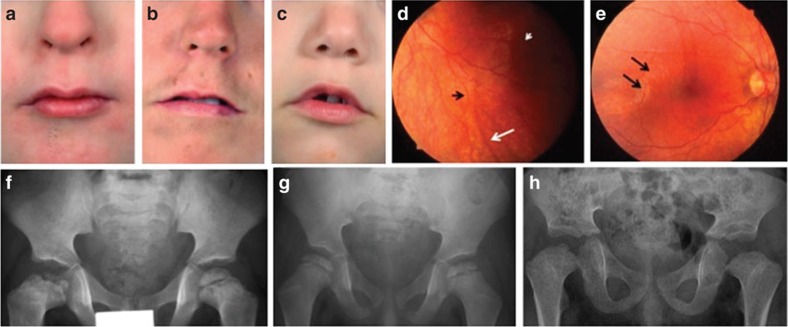
Facial, retinal and skeletal features of Roifman Syndrome.Facial dysmorphic features (a–c) include a markedly long philtrum, thin upper lip and down-turned corners of the mouth. Retinal features are displayed for patient 3 at age 4 years: arteriolar attenuation (d, black arrow), wrinkling of the inner limiting membrane (d, short white arrow and e, black arrows) and pigmentary changes (d, long white arrow). Skeletal features are displayed for patients 1, 3 and 5, respectively: the radiographs show the proximal epiphyses of the femora with symmetric delayed ossification, as well as flattening and irregularity.